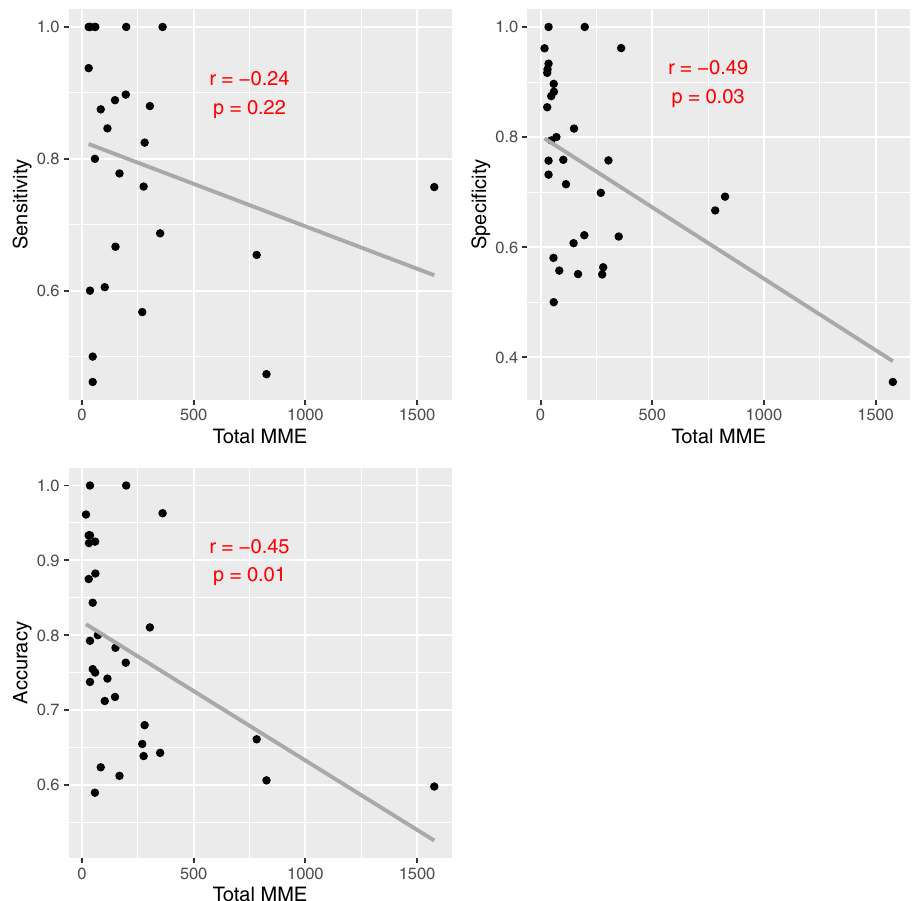
Fig. 5 Model metrics vs. total MME administered. R and P values based on Pearson correlation. MME morphine milligram